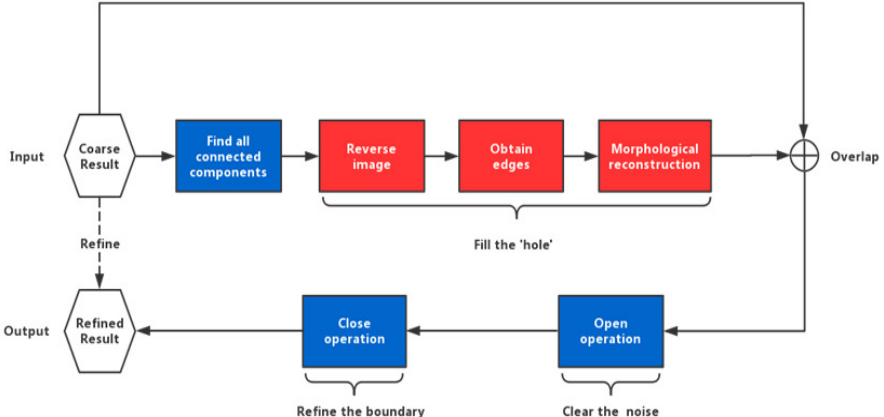
Figure 7. The pipeline of the morphological processing layer. The input (Coarse Result) is a binary image which is generated from U-net. First, all connected components of the Coarse Result are computed. Then, all ‘hole’ filling procedures (Reverse image, Obtain edges, Morphological reconstruction) are performed. Next, overlap the Coarse Result with the result of ‘hole’ filling. After that, the Open operation is performed to clear noise. In the next step, the Close operation is performed to refine the boundary of the result. Finally, the Refined Result is the